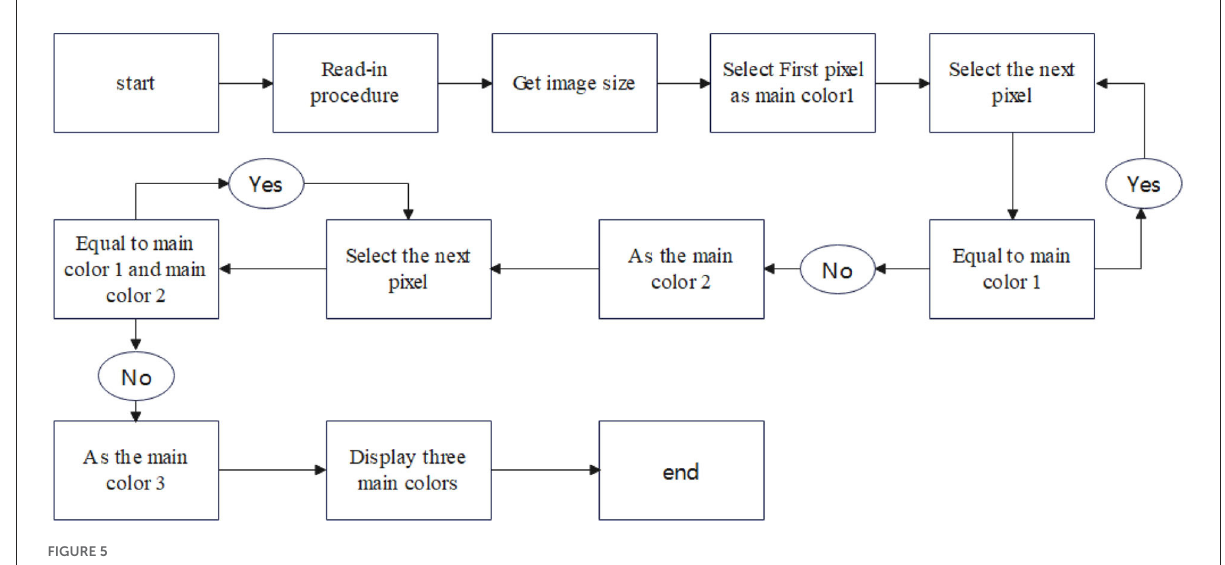
FIGURE5 Block diagram of main color extraction